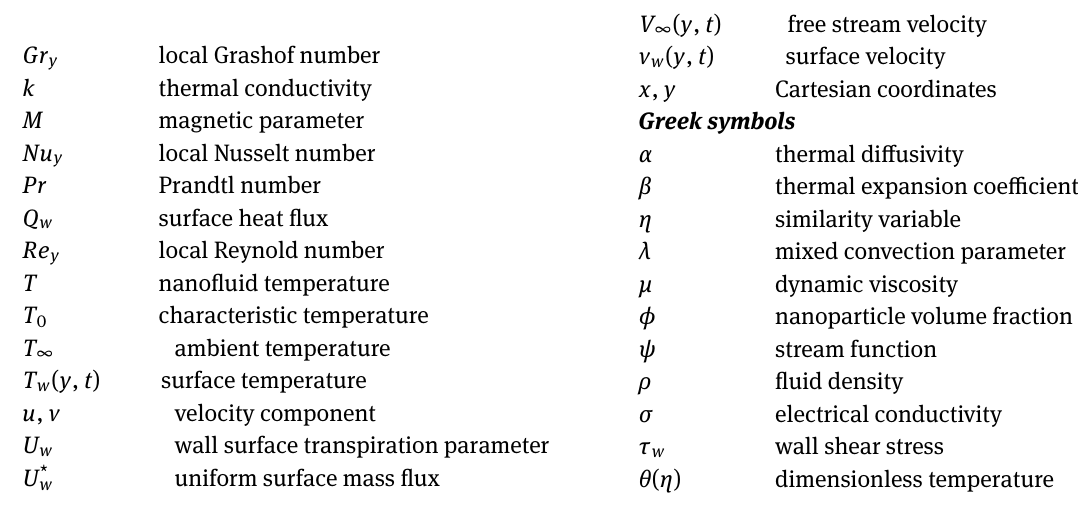
Fig. 14: The temperature distribution for alumina-sodium alginate nanofluid for different values of magnetic and wall transpiration parameters with A = 0.5, ε = 0, λ = 1, Pr = 6.2, ϕ = 0.2.